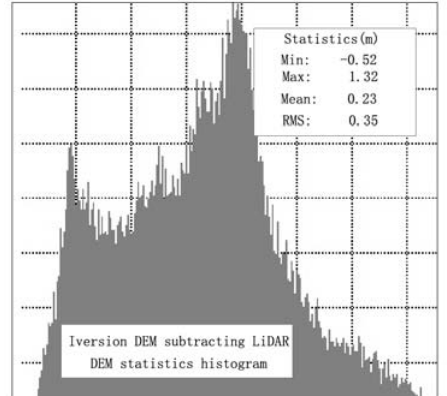
Figure.13 Histogram of error statistics of inversion and